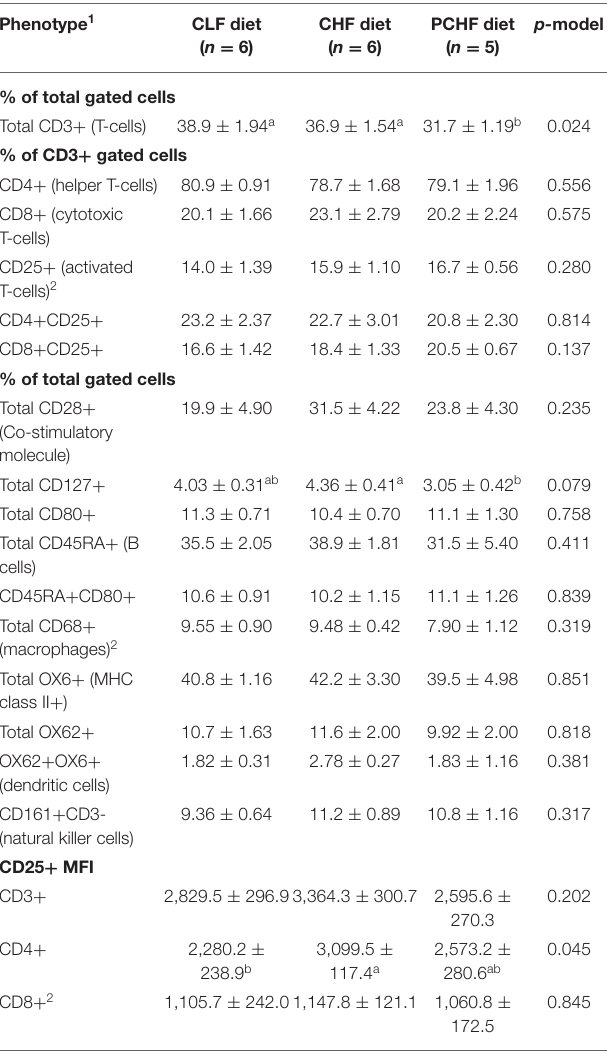
TABLE 5 | Splenocyte phenotype of male Wistar rats fed the three experimental diets. Phenotype